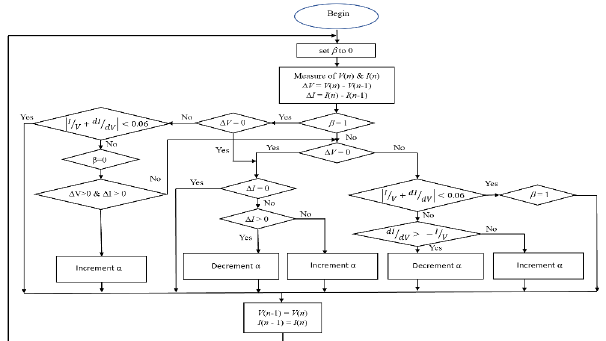
Figure 11: P-V and I-V curves for solar irradiation of 300 W/m2 and 1000 W/m 2